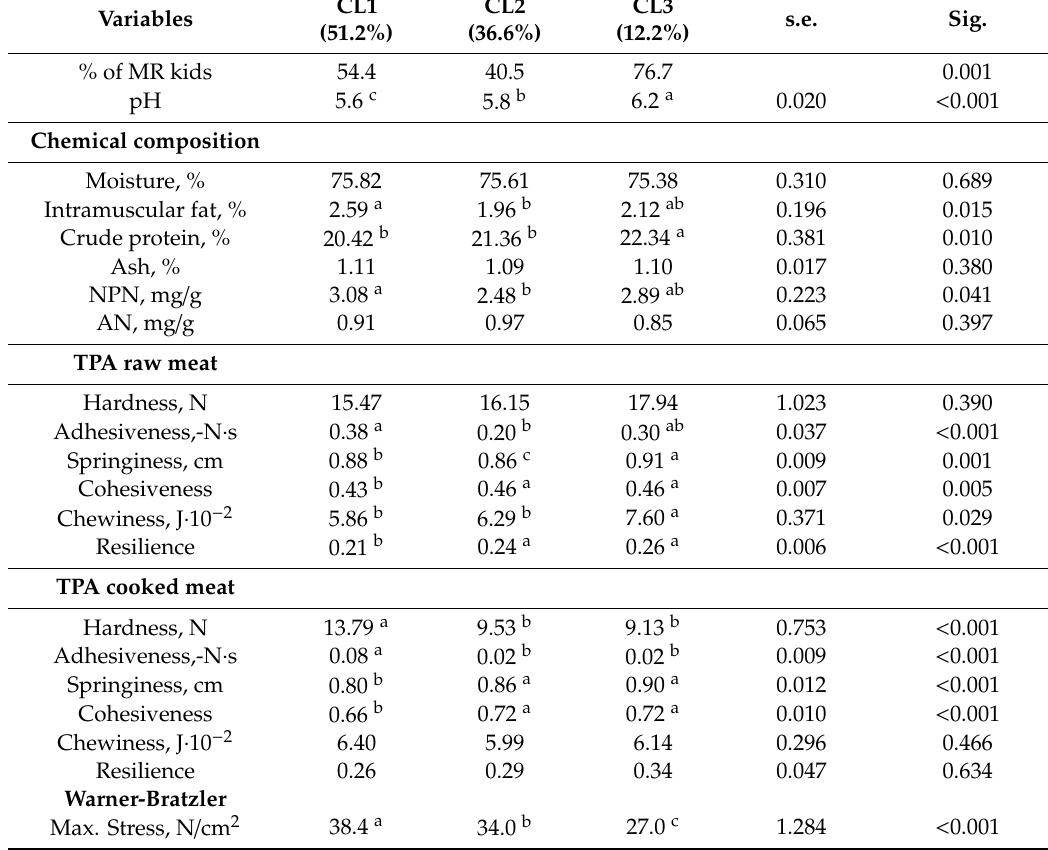
Table 5. Comparison of meat pH on chemical composition and texture of meat of the three pH clusters identified by the k -means algorithm. The percentage of kids per cluster is between